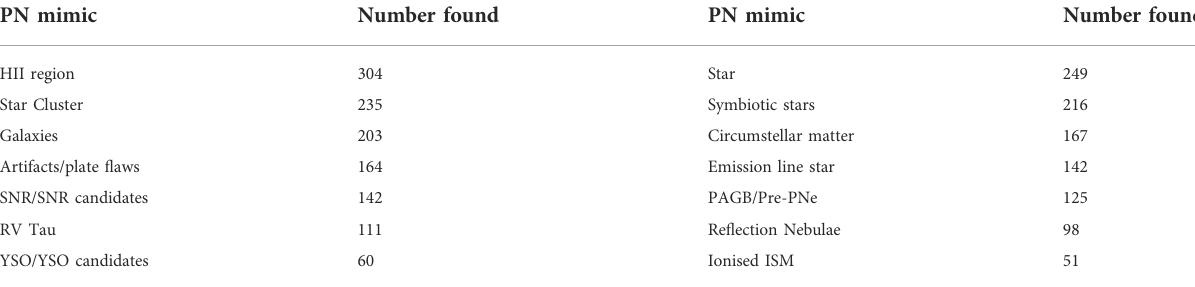
TABLE 2 List and numbers of the most common PN mimics from among the 41 different non PNe classi fi cations used in HASH. PN mimic Number found PN mimic Number